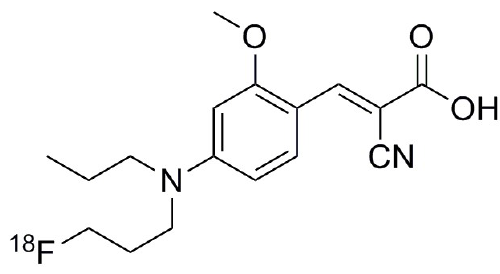
Figure 4. Chemical structure of [ 18 F]FACH.